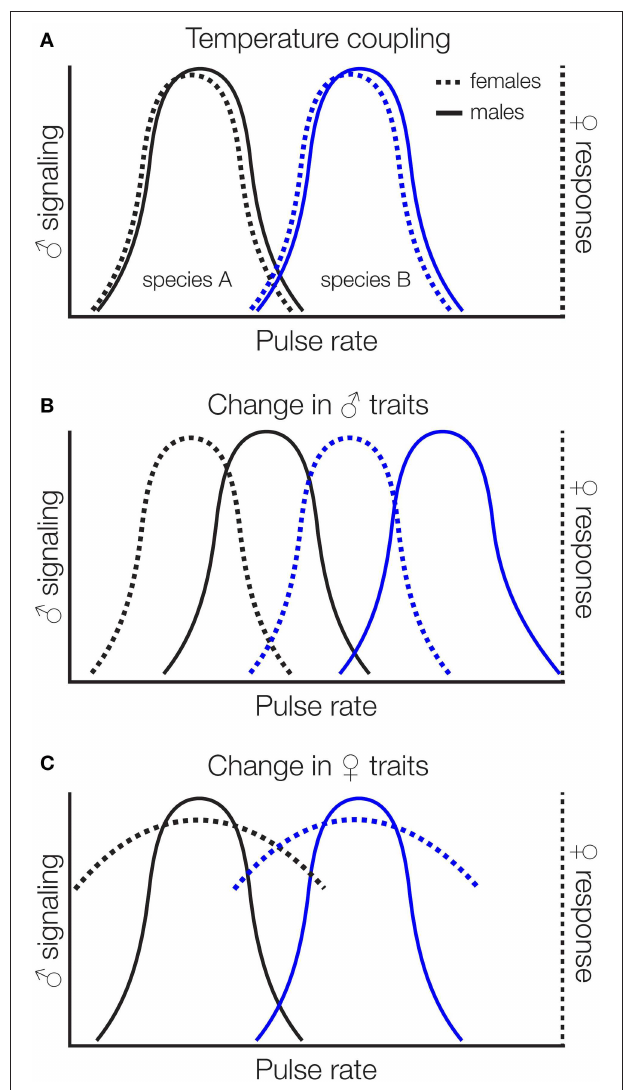
FIGURE 3 | Potential impacts of climate change on temperature dependent signals and preferences. Signals and chooser preferences are typically coupled (A) . If increased mean temperatures, for instance, shift signals but not chooser preferences (B) , or chooser preferences but not signals (C) , or signals and preferences shift differentially (not shown), we might expect mismatches that lead to heterospecific mating. In (C) we show one possible shift in chooser preferences (more “relaxed” preference functions with high relative chooser responsiveness that encompasses more signal values), but shifts in peak preference and other characteristics are also